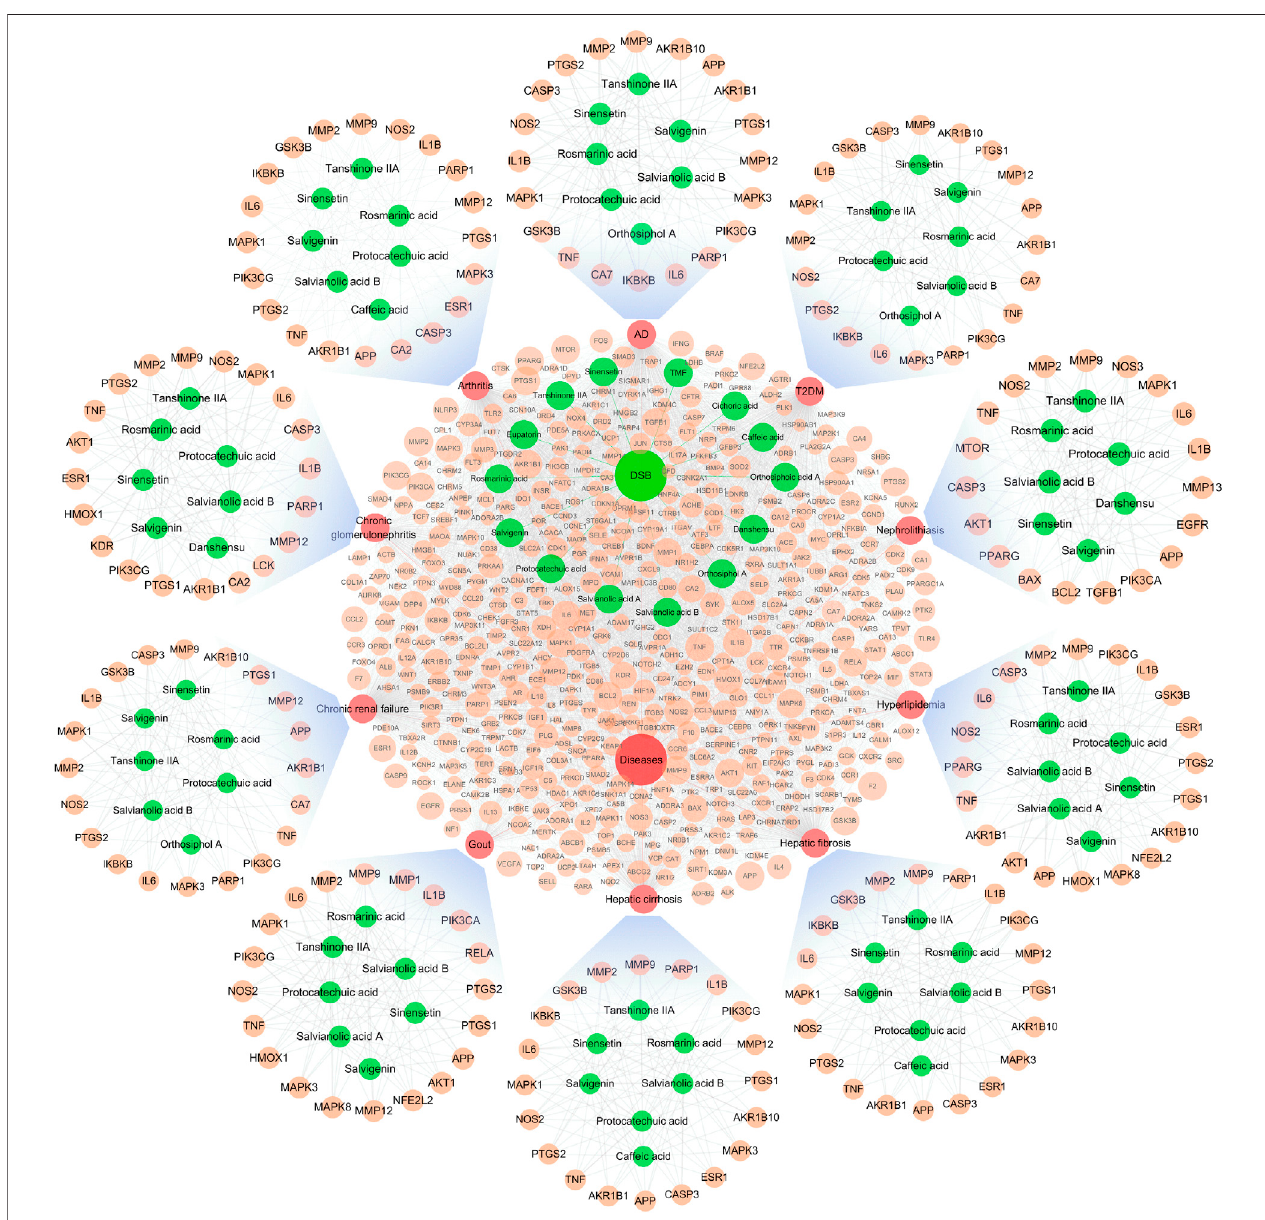
FIGURE4| Networkvisualizingtheoverallinteractionofconstituents andtargets, withintegratedsub-networkvisualizingthetopconstituentsand targetsforeach OSB-disease pair. AD, Alzheimer ’ s disease; OSB, Orthosiphon stamineus Benth.; T2DM, type 2 diabetes mellitus. TMF, 3 ′ -Hydroxy-5, 6, 7, 4 ′ -tetramethoxy fl avone.